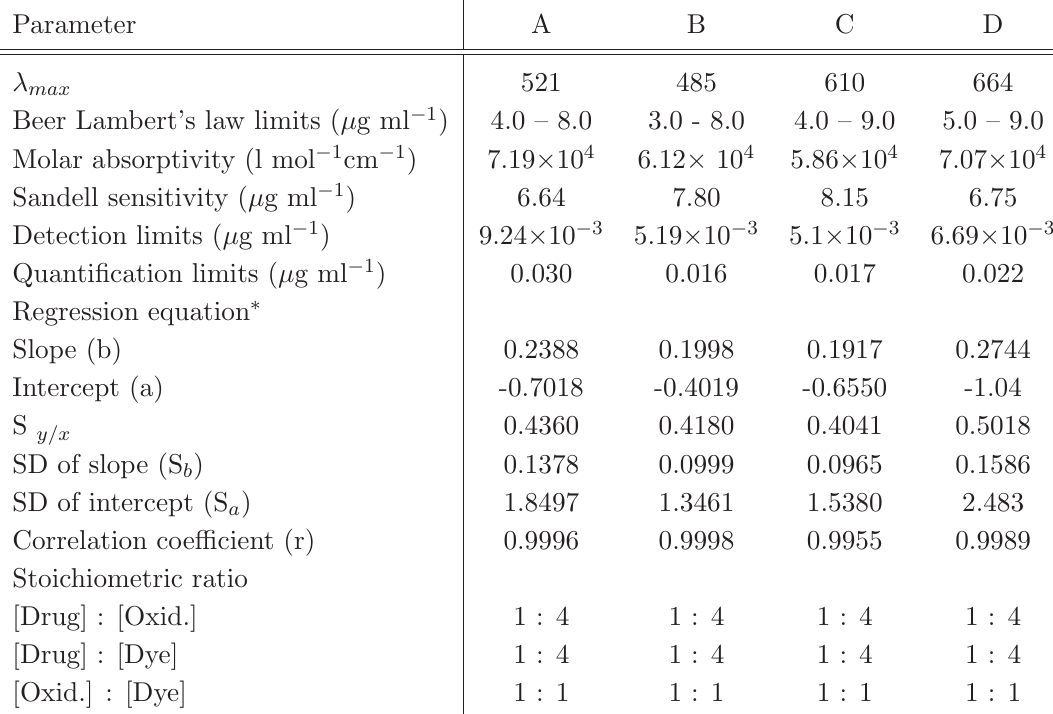
Fig. 4 Molar ratio plot for the reaction of 1.0 × 10 − 4 M vancomycin and 1.0 × 10 − 4 M KMnO with: (a) AM (b) AO (c) Indigo and (d) MB. 4 Table 1 Analytical parameters and optical characteristics of the proposed methods with gentamicin